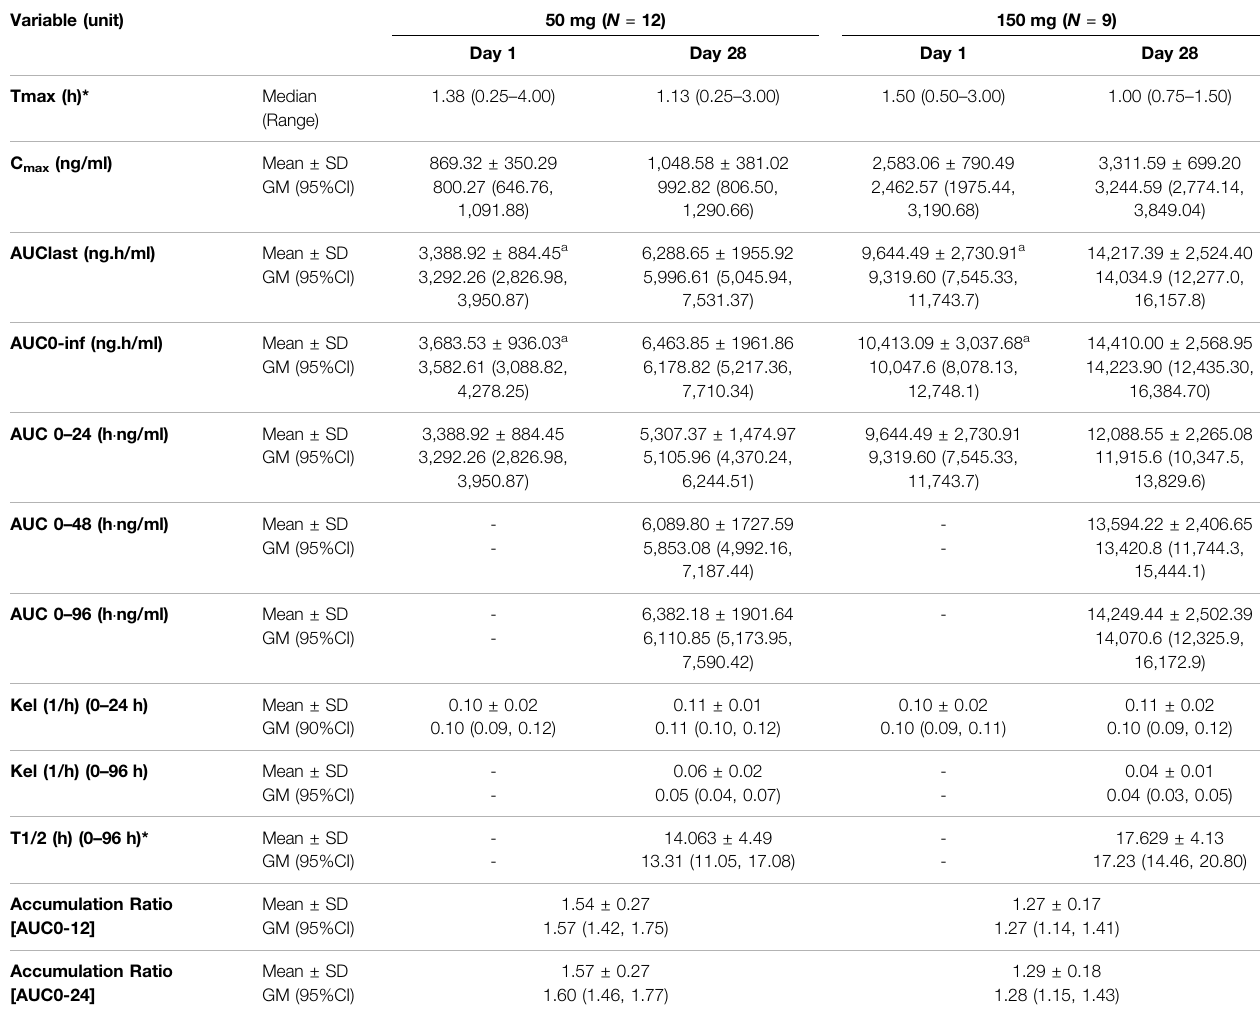
TABLE 5 | Summary of PK parameters of multiple dose study (MAD). Variable